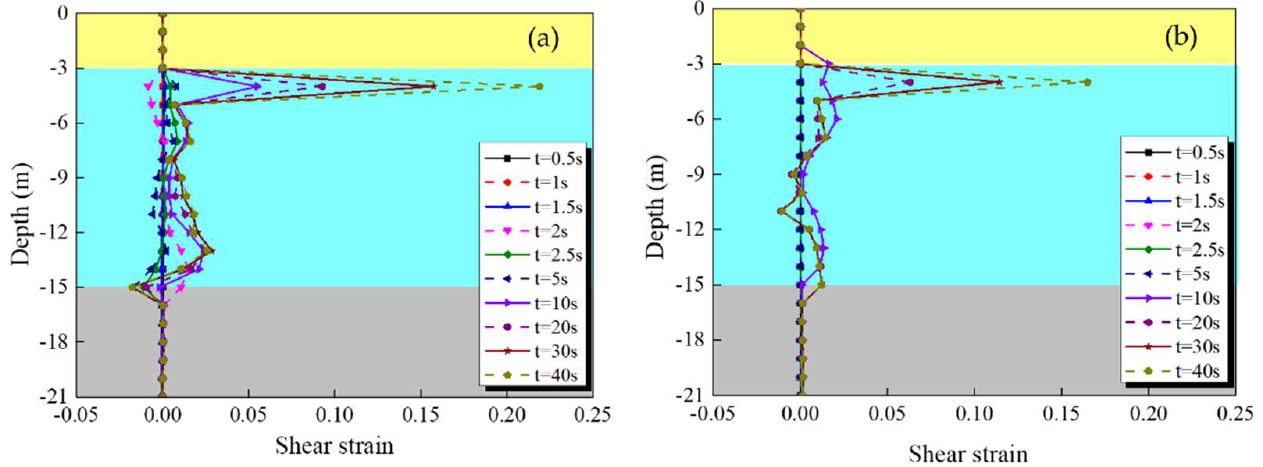
Figure 8. Distribution of EPWP along soil depth at different moments ( a ) under the El-Centro motion; ( b ) under the Kobe Motion.